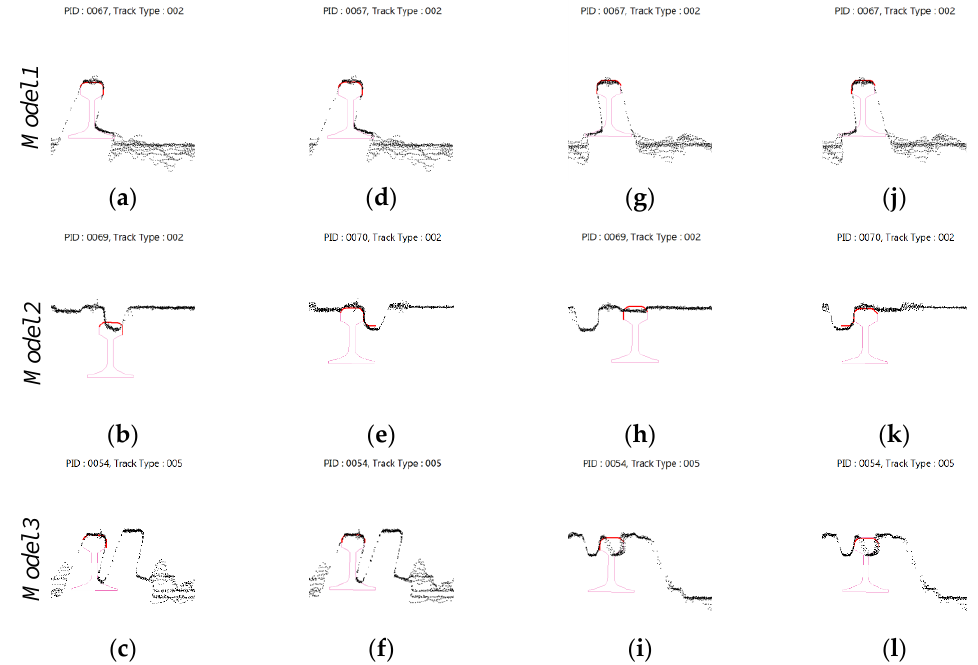
Figure 13. GC detection results of the left rail track by the conventional track extraction method: ( a ) ideal track, ( b ) near crossing and ( c ) near turnout and the proposed track extraction method: ( d ) ideal track, ( e ) near crossing and ( f ) near turnout. GC detection results of the right rail track by the conventional track extraction method: ( g ) ideal track, ( h ) near crossing and ( i ) near turnout and the proposed track extraction method: ( j ) ideal track, ( k ) near crossing and ( l ) near turnout. Table 3. Structure detection results—Railway line A.